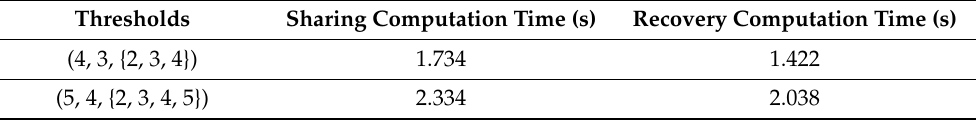
Table 2. Performance of sharing and recovery procedures at different thresholds.